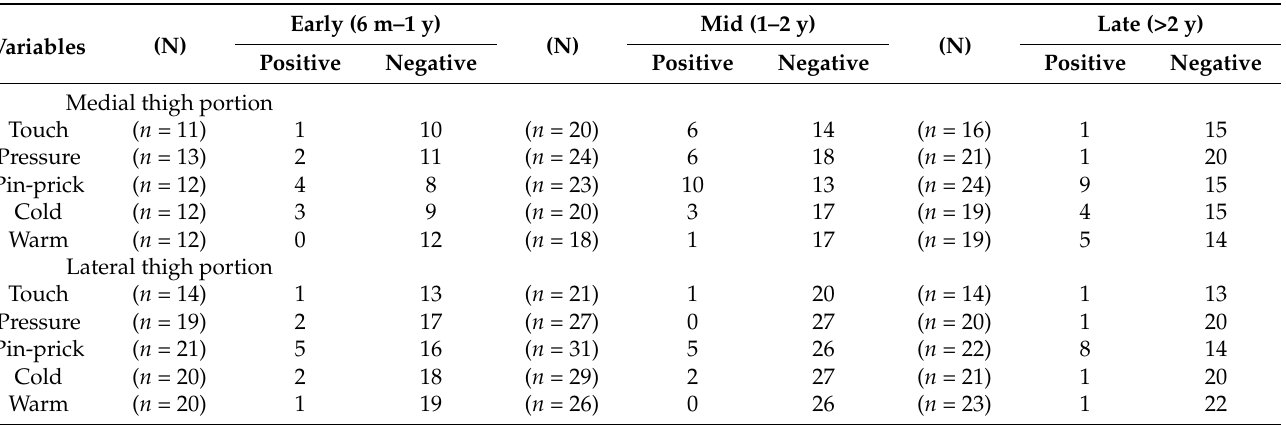
Table 4. Abnormal senses with different stimuli on the medial and lateral donor thigh skin following anterolateral thigh flap surgery.